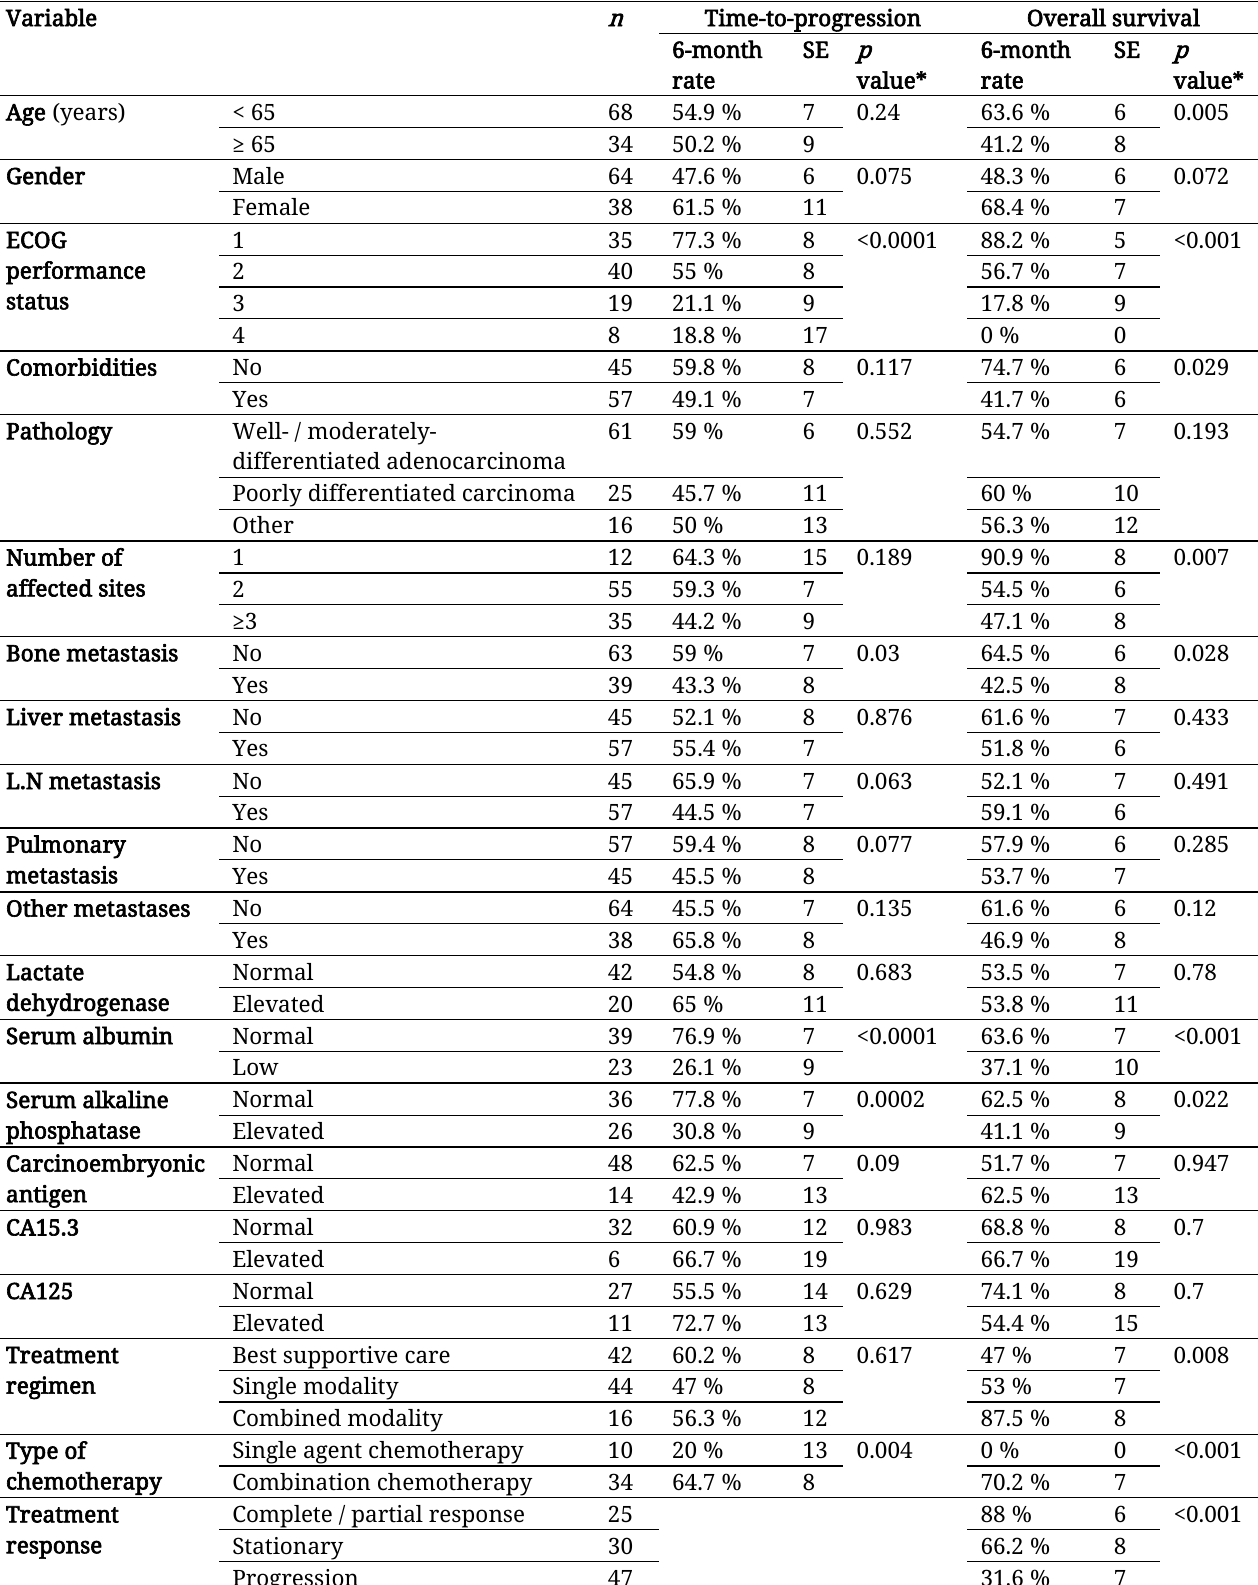
Table 3: The relation between the studied variables and time-to-progression and overall survival